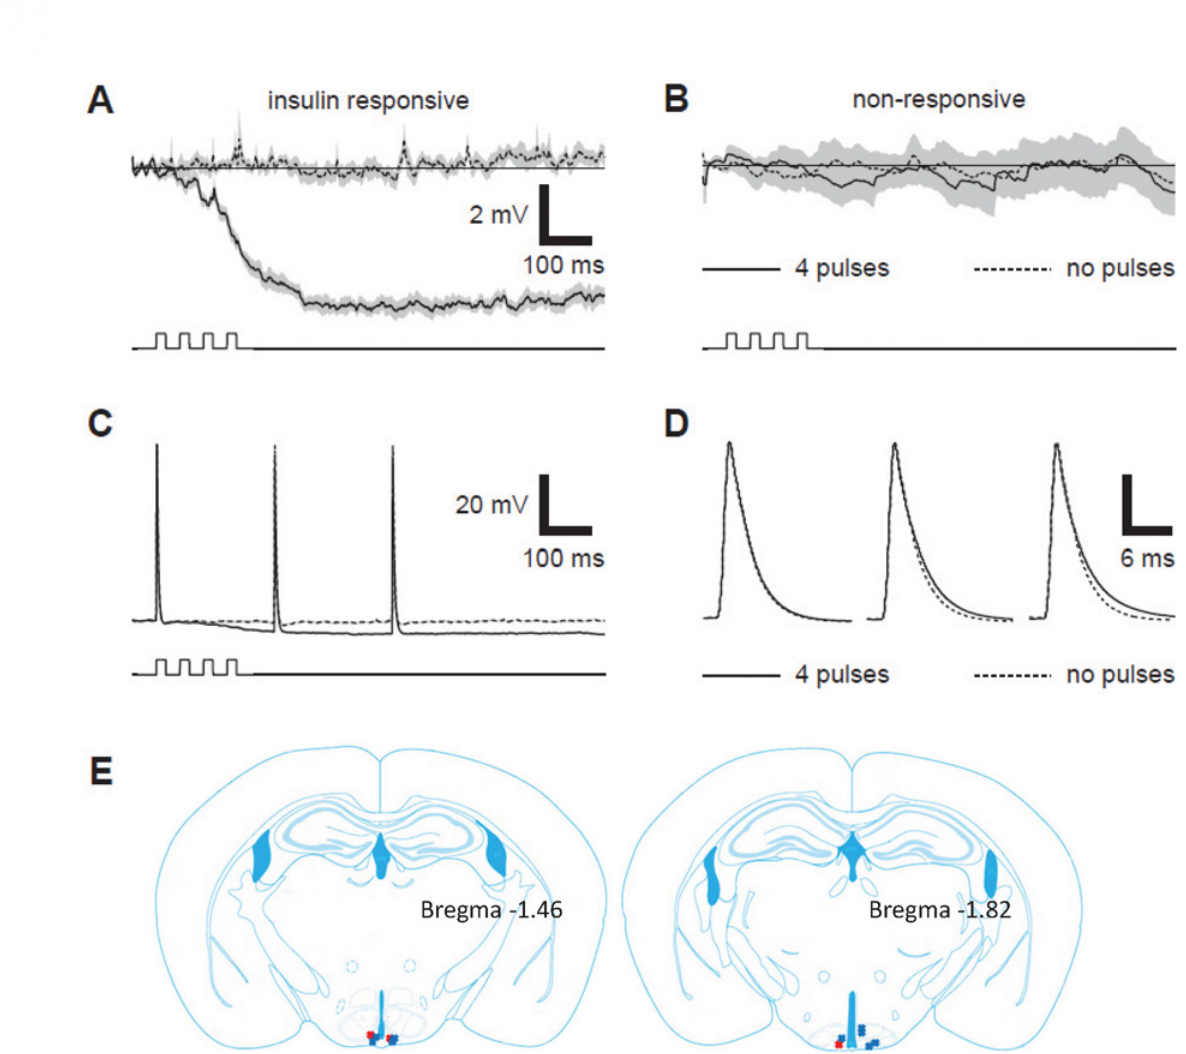
Fig 1. Electrophysiological response of Kiss1 neurons to insulin. A: Averaged membrane potential (Vm) recordings from an insulin-responsive Kiss1 neuron elicited with (solid line) and without (dashed line) a 4 x 20 ms pressure application of 200 nM insulin in ACSF. Gray shading represents the mean ± SEM from traces averaged across 11 repetitions obtained every 10 sec. B: same as A with recordings averaged across 11 repetitions from a Kiss1 neuron that did not respond to pressure pulses of 200 nM insulin. Time course of pressure pulses is shown below Vm traces in A — B. C: recordings from same neuron in A in which APs were elicited by 0.2 ms depolarizing current pulses during (solid line) and without (dashed line) 4 x 20 ms pressure application of 200 nM insulin in ACSF. D: APs from C displayed on magnified time scale and aligned at peak to identify whether any changes occurred in AP time course. E: Locations of recordings from EGFP positive Kiss1 neurons. Red Xs represent insulin-responsive neurons, and the blue Xs represent insulin nonresponsive neurons. Modified from Mouse Brain in Stereotaxic Coordinates , 3 rd Edition by Franklin and Paxinos (used with permission).